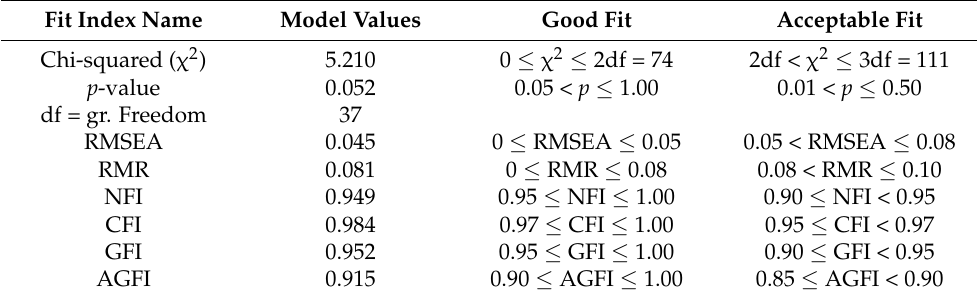
Table 8. Model adjustment rates associated with the MBI-GS questionnaire.